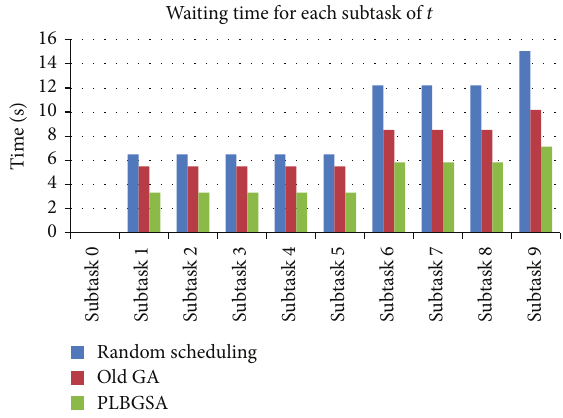
Figure 13: Waiting time for each subtask of 𝑡 with random scheduling, old GA, and